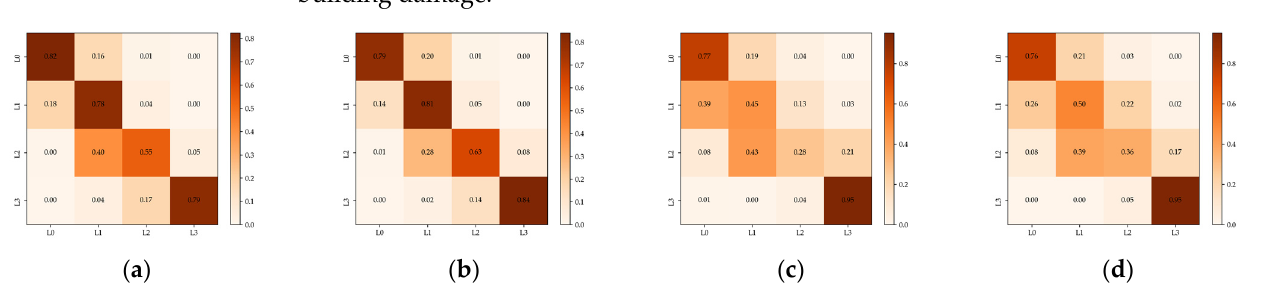
Figure 6. Confusion matrix in Group 3: ( a ) baseline in the Ludian dataset; ( b ) EBDC-Net in the Ludian dataset; ( c ) baseline in the Yushu dataset; ( d ) EBDC-Net in the Yushu dataset.